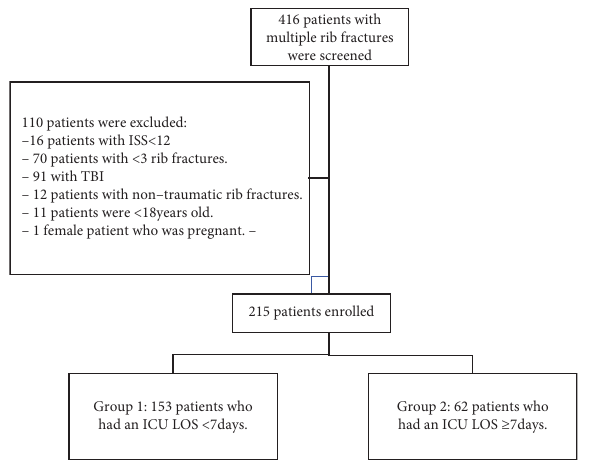
Figure 1: Screening and analysis flowchart.